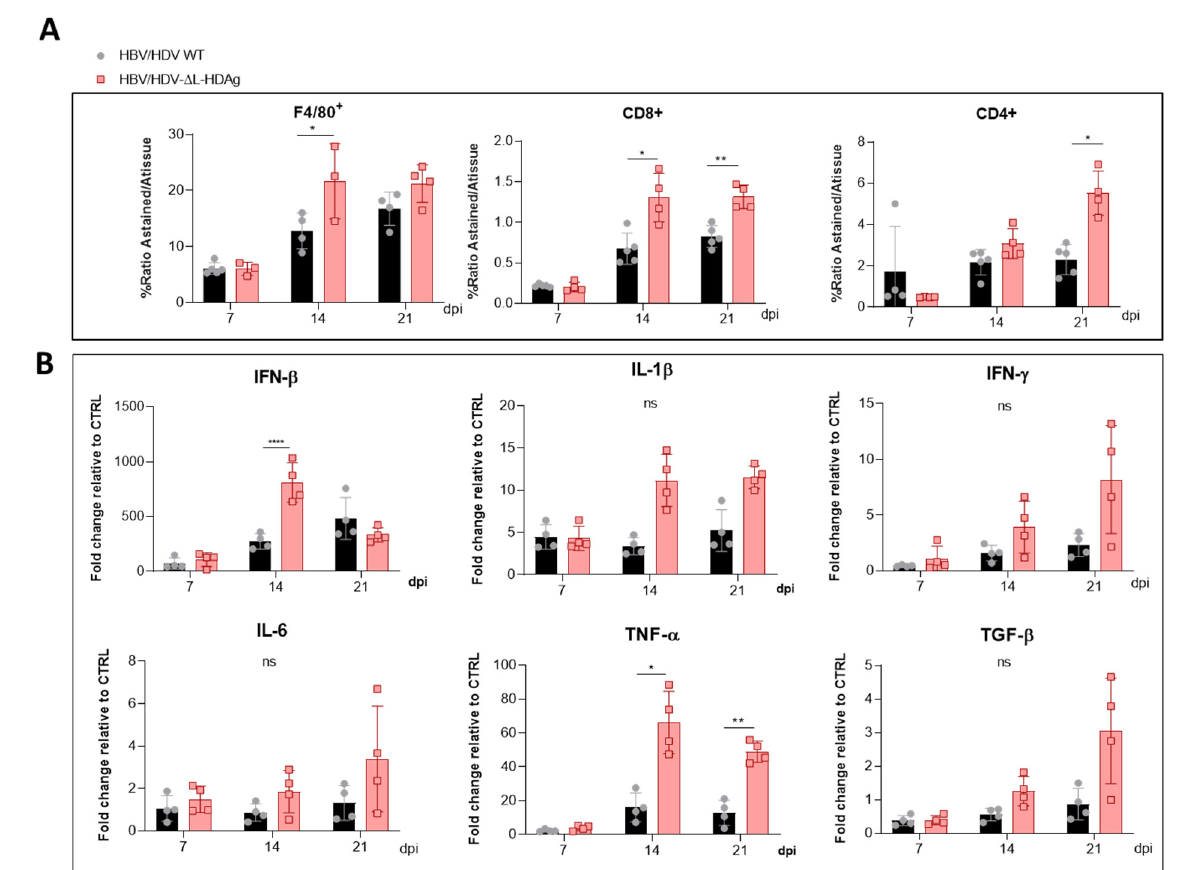
Figure 5. The HDV mutant expressing only S-HDAg increased the recruitment of inflammatory cells and the expression of cytokines. Liver sections collected at 7, 14 and 21 dpi of AAV-HBV/HDV WT- and AAV-HBV/HDV- Δ L-HDAg-injected mice were subjected to ( A ) F4/80-, CD4- and CD8 immunostaining to quantify the percentage of intrahepatic macrophages and CD4+ and CD8+ T lymphocytes, respectively, and ( B ) The expression levels of IFN- β , IFN- γ , IL-1 β , IL-6, TNF- α and TGF- β were analyzed by RT-qPCR. Significant differences between groups at each time point were determined by a two-way ANOVA followed by Bonferroni’s multiple-comparison test. ns: no significant, * p < 0.05, ** p < 0.01, **** p < 0.0001.